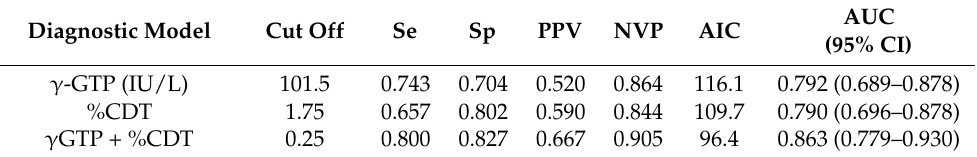
Table 3. Comparison of AUC for γ -GTP alone, %CDT alone, and their